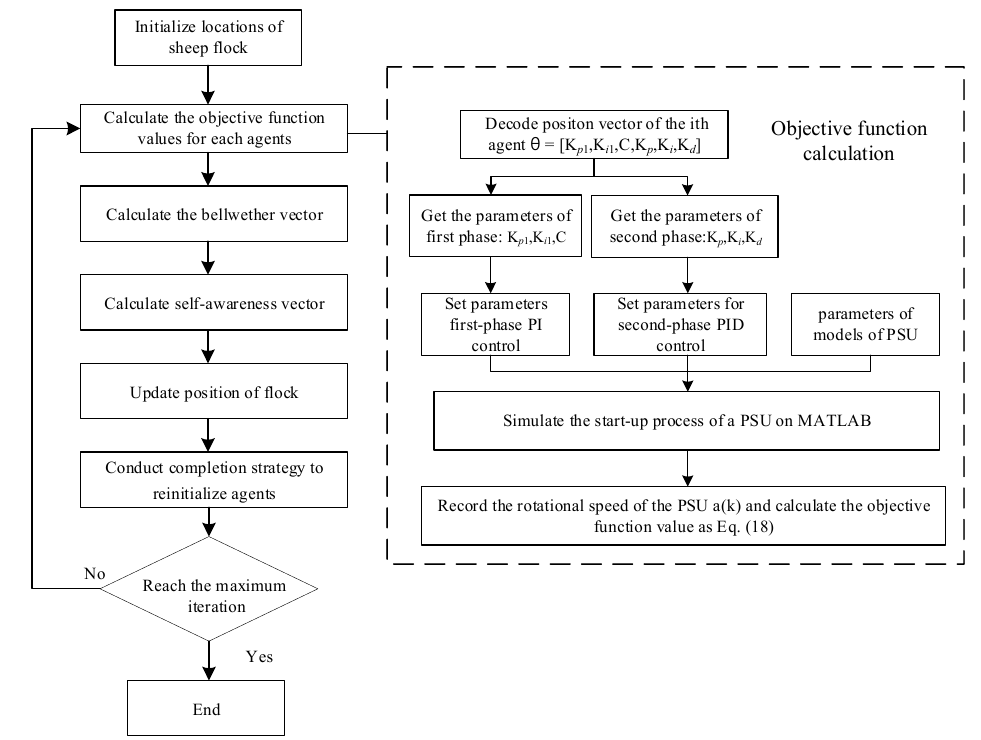
Figure 13. The detail flow chart of parameters optimization.